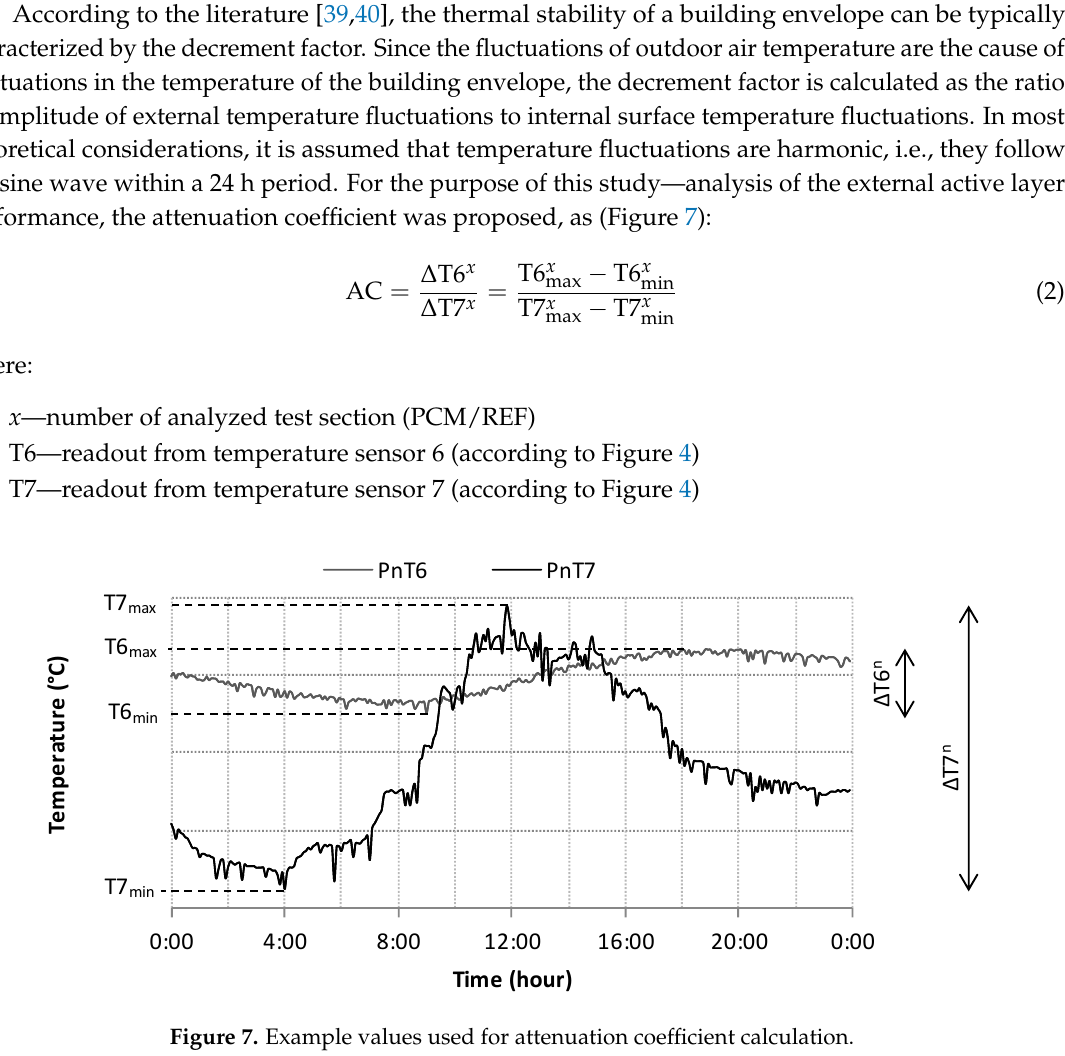
Figure 7. Example values used for attenuation coefficient calculation.